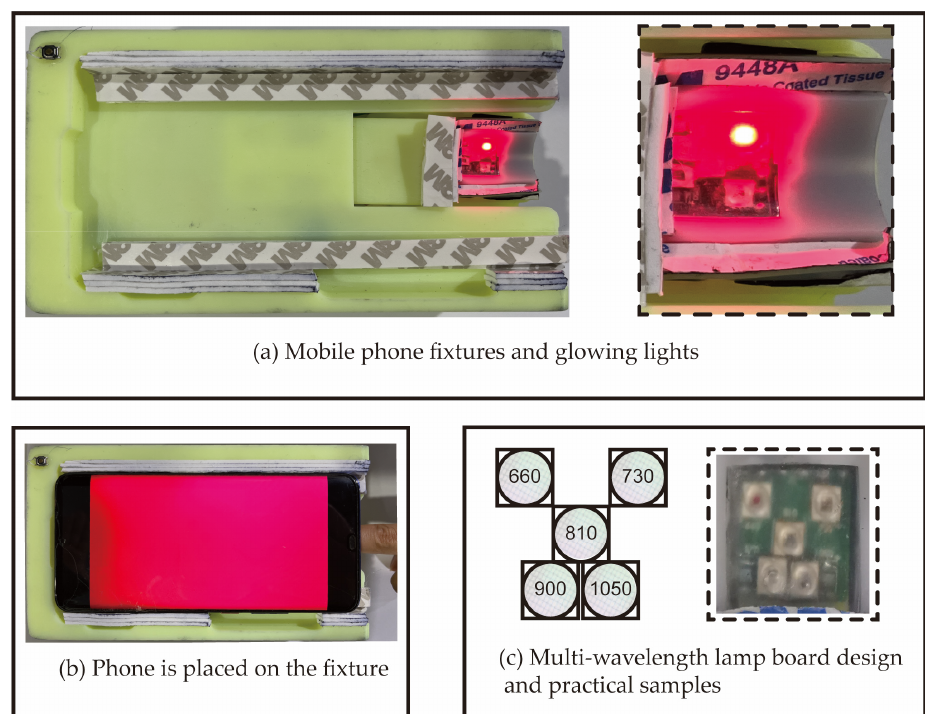
Figure 2. Hardware device for data collection: ( a ) Smartphone fixture with 660 nm LED on. ( b ) Smartphone on the fixture. ( c ) Arrangement of five-wavelength LEDs.